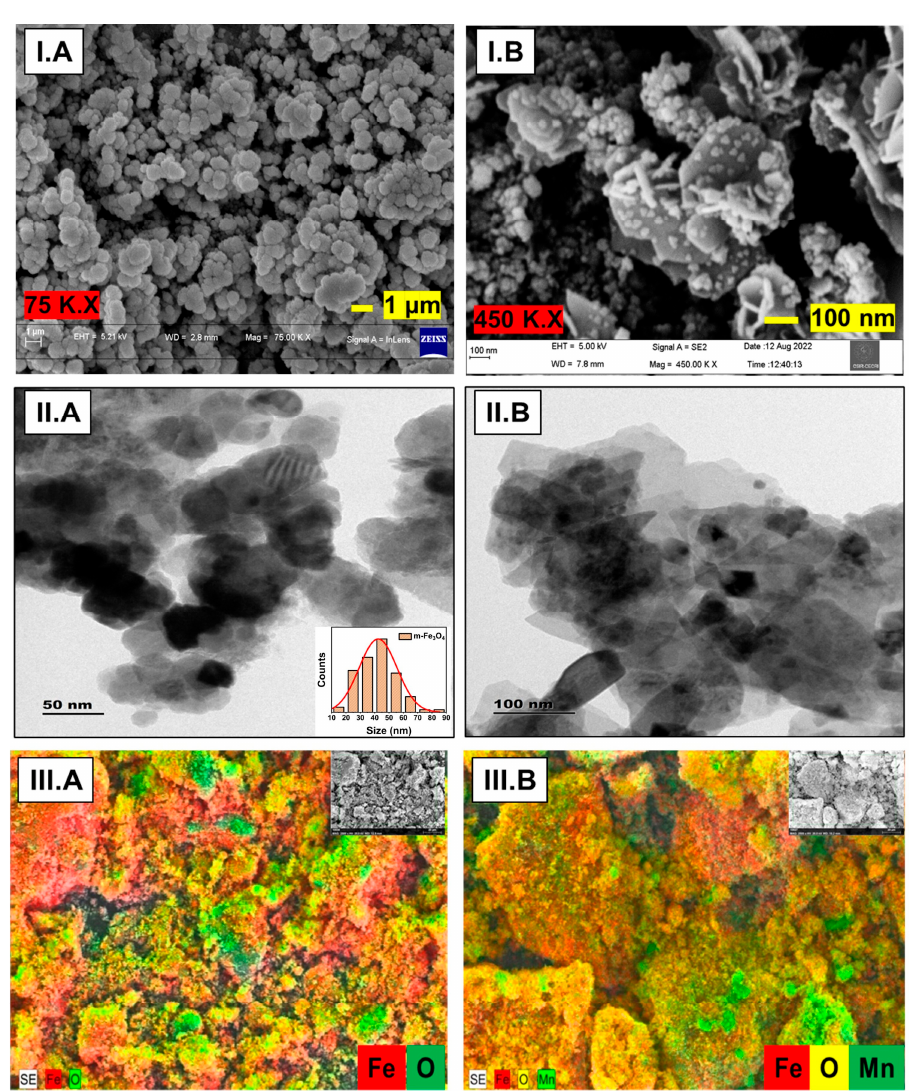
Figure 4. FESEM ( I ), HRTEM ( II ), and elemental mapping ( III ) of ( A ) m-Fe 3 O 4 and ( B ) m-Fe 3 O 4 @MnO 2 nanocomposites.